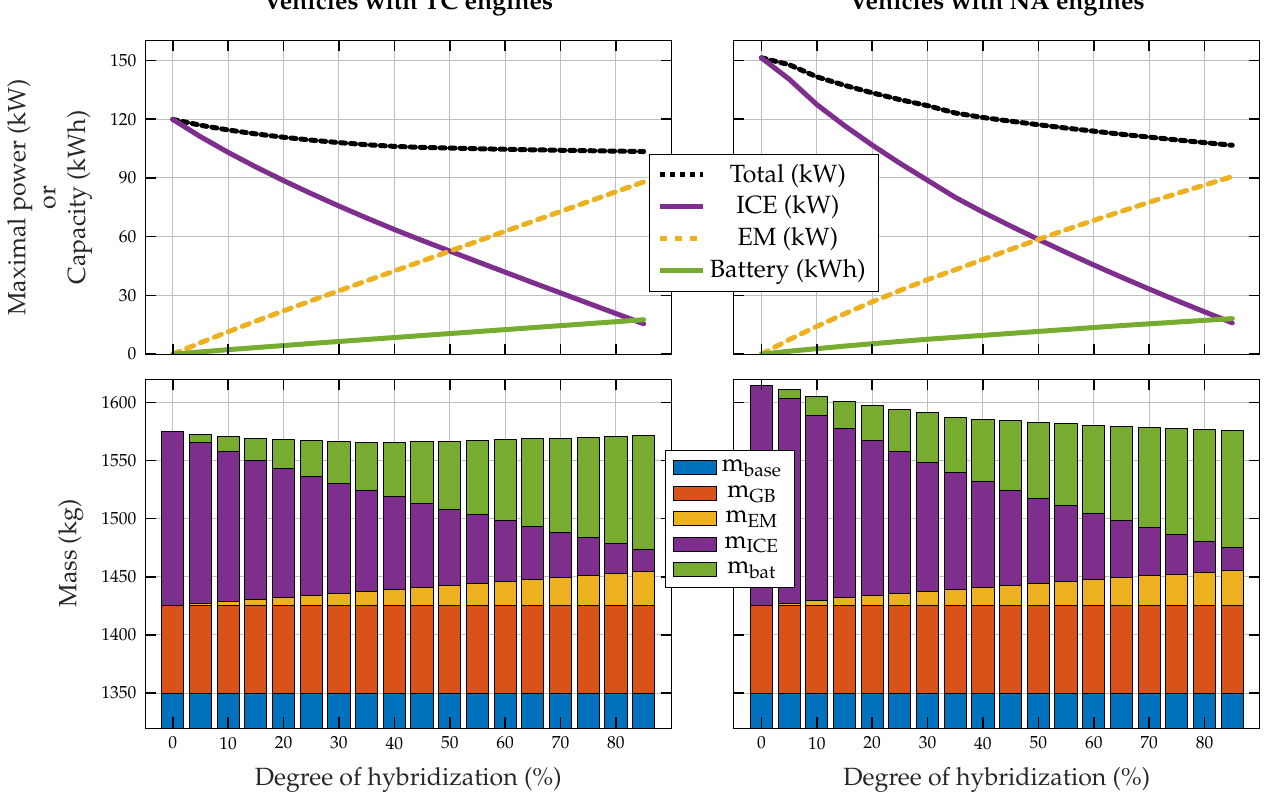
Figure 7. Effects of the degree of hybridization on the maximal power and the mass distribution of the vehicle and its components. The plots on the left-hand side show the results from vehicles equipped with a turbocharged ICE, while the plots on the right-hand side show the results from vehicles with naturally aspirated ICEs.